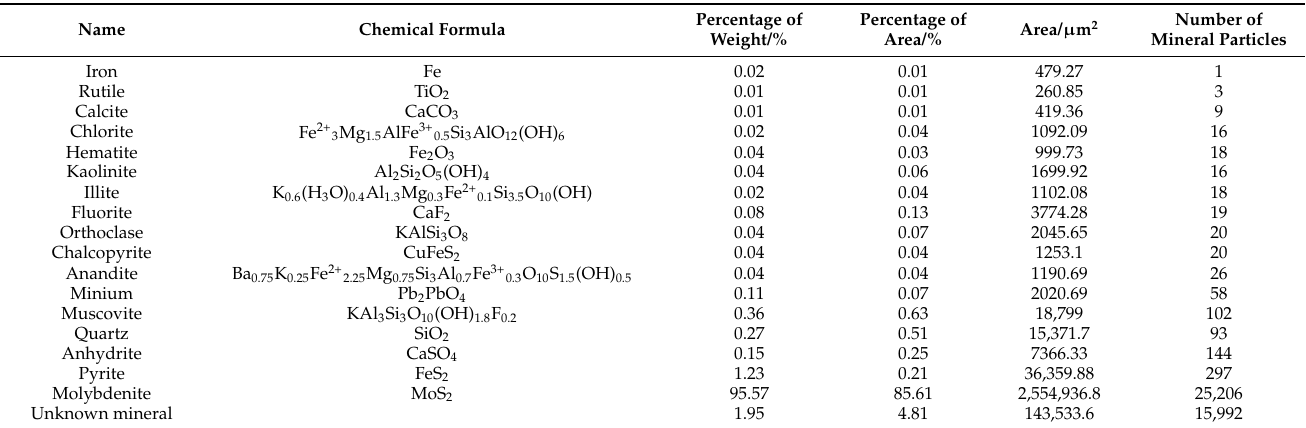
Table 2. Mineral phase and content of molybdenum concentrate determined by